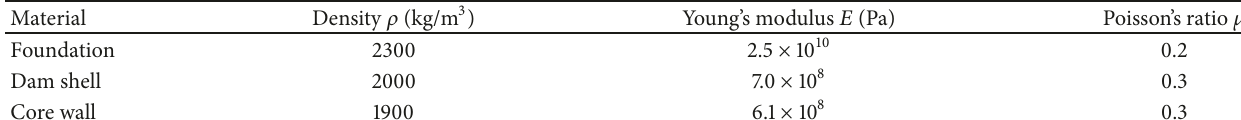
Table 1: Calculation parameters.